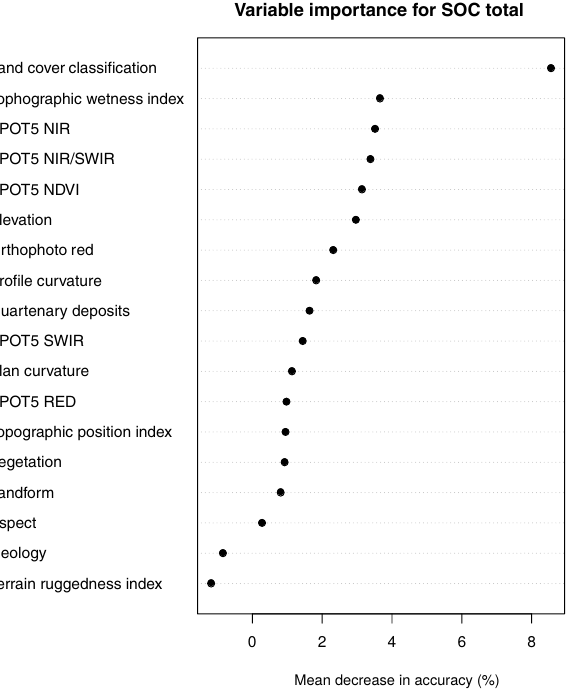
Figure 6. Variable importance for the prediction of total SOC mea- sured as mean decrease in accuracy of the random forest model if the variable is excluded. The higher the value the more important is the